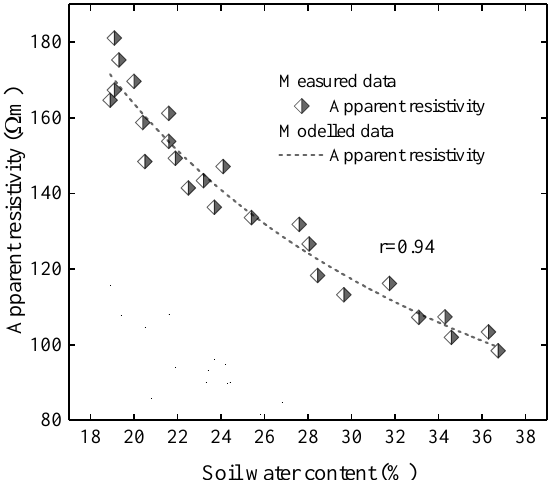
Figure 3. Soil water content–apparent resistivity relationship for the formation determined from in situ monitoring and fitted by Archie model.